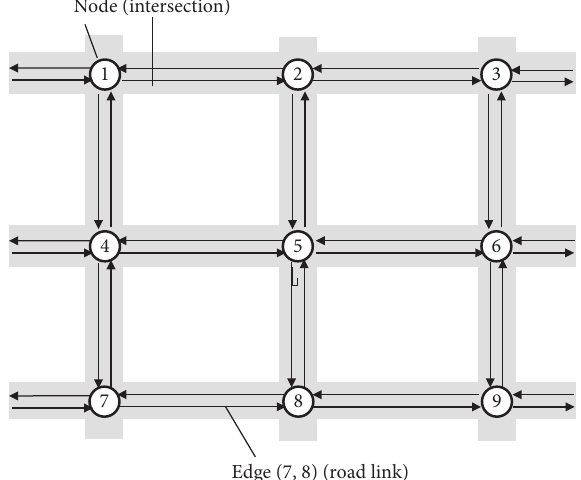
Figure 3: The directed graph of the road network.